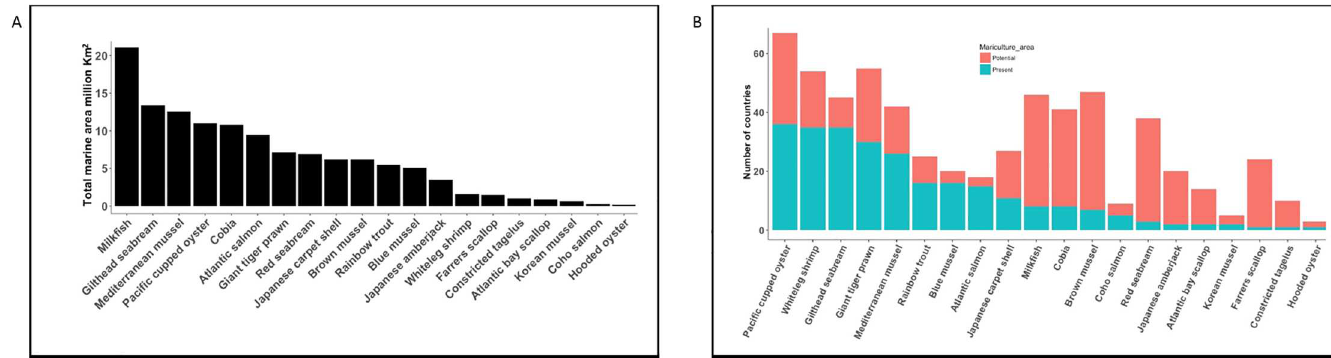
Fig 8. Total predicted potential mariculture area for 20 of the most cultured species based on cumulative production from 1950–2010. (A) Classification by total potential marine areas suitable for farming. (B) Classification by total present and potential number of countries.